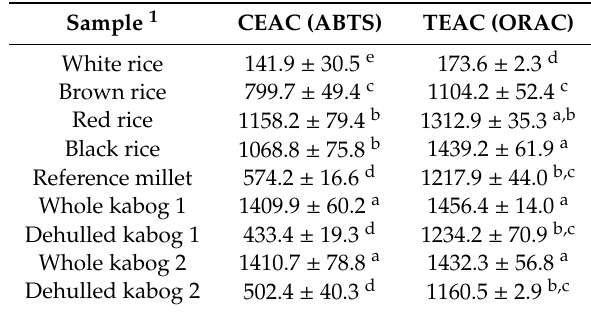
Figure 4. %Inhibition of DPPH (radical scavenging activity, RSA) and ABTS (radical cation scavenging activity) of rice (white, brown, red, and black), reference millet, and kabog millet (whole and dehulled) samples. Values followed by the same letters are not significantly di ff erent at p < 0.05 using one-way ANOVA Tukey’s HSD. Table 3. CEAC and TEAC values in the ABTS and ORAC antioxidant assays, respectively, of rice (white, brown, red, and black), reference millet, and kabog millet (whole and dehulled)